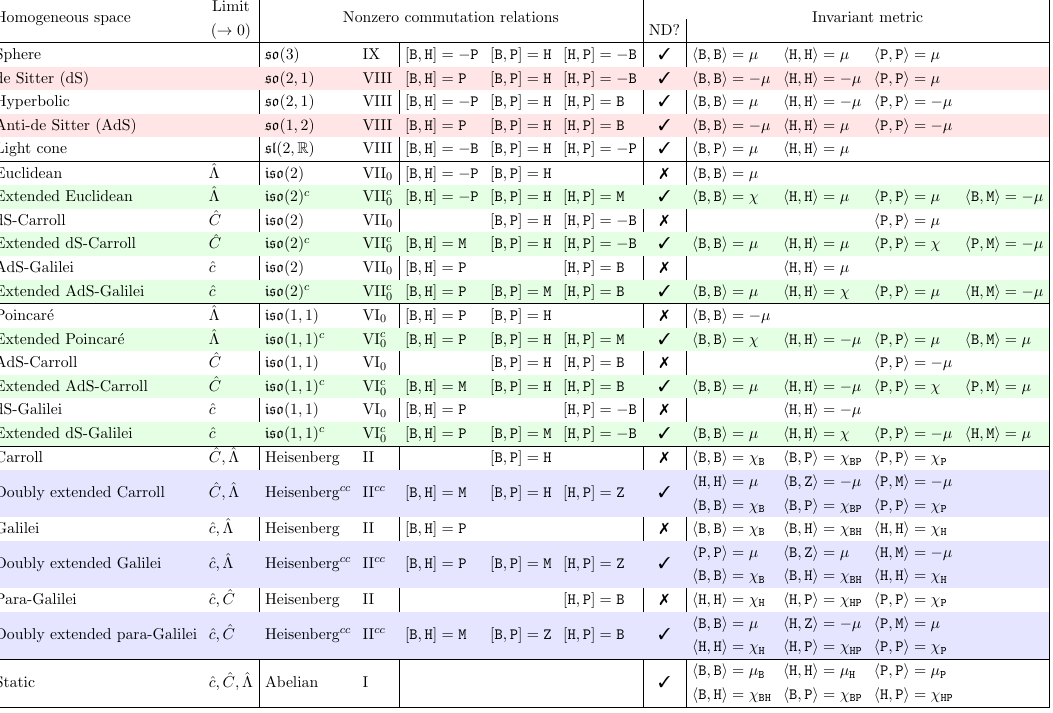
Table 1 . Overview of homogeneous spaces/Klein pairs ( g ; B ), underlying Lie algebras g and their invariant metric (‘ND?’ indicates Non-Degeneracy). The real Lie algebras are indicated by their names and according to Bianchi’s classi(cid:12)cation [64, 65]. Superscripts c denote nontrivial central extensions. Rows in red are Lorentzian versions of the previous row, rows in green (blue) are centrally extended once (twice) and arise as limits of sl (2 ; R ) (cid:8) u (1) ( sl (2 ; R ) (cid:8) u (1) (cid:8) u (1)), see section